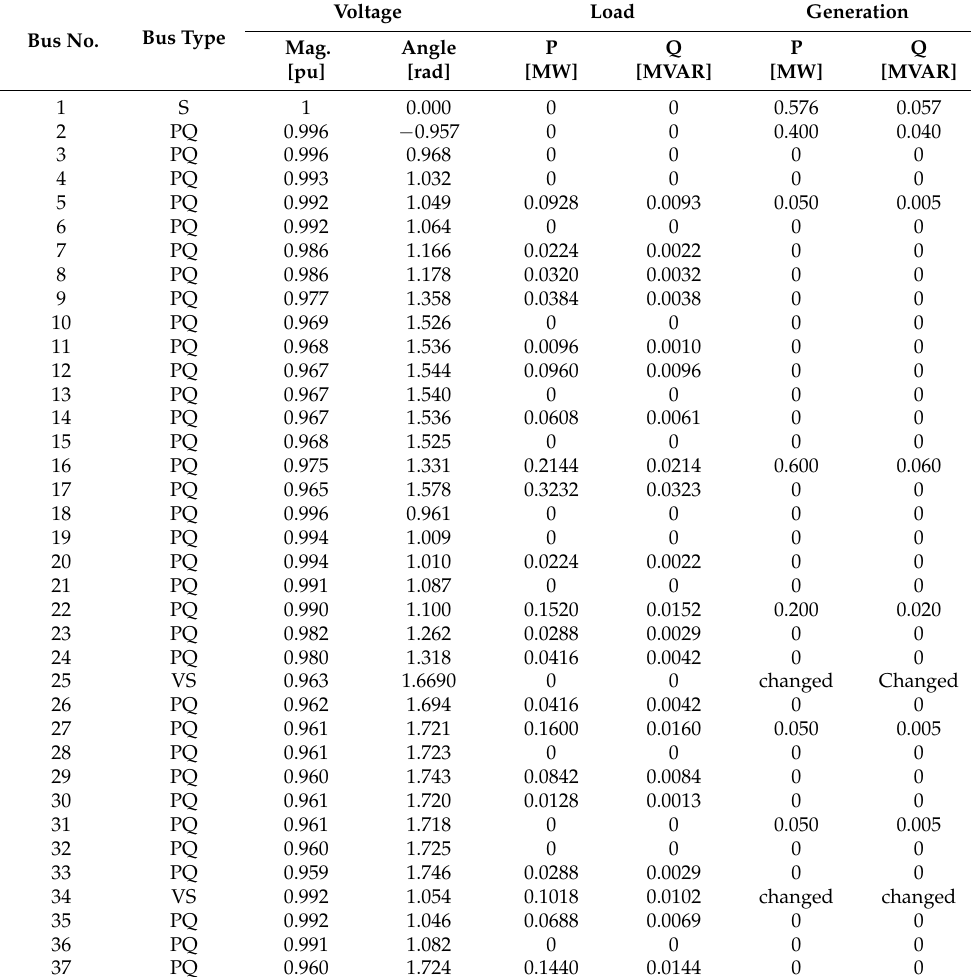
Table A1. Bus data of the stand-alone